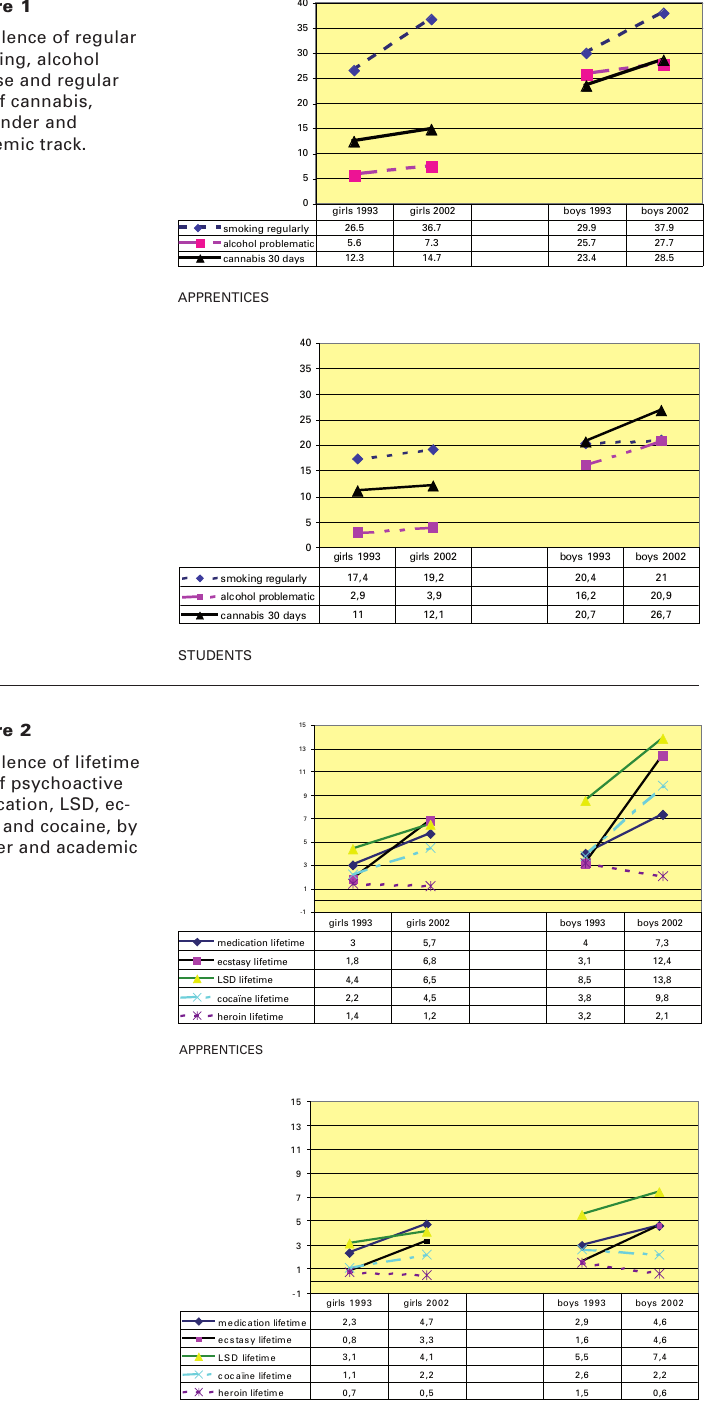
Figure 2 Prevalence of lifetime use of psychoactive medication, LSD, ec- stasy and cocaine, by gender and academic